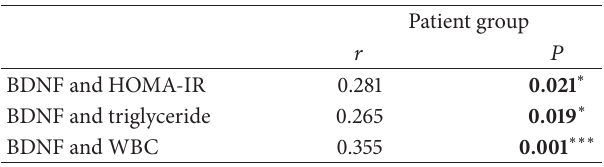
Table 3: Logistic regression analysis of independent factors associ- ated with